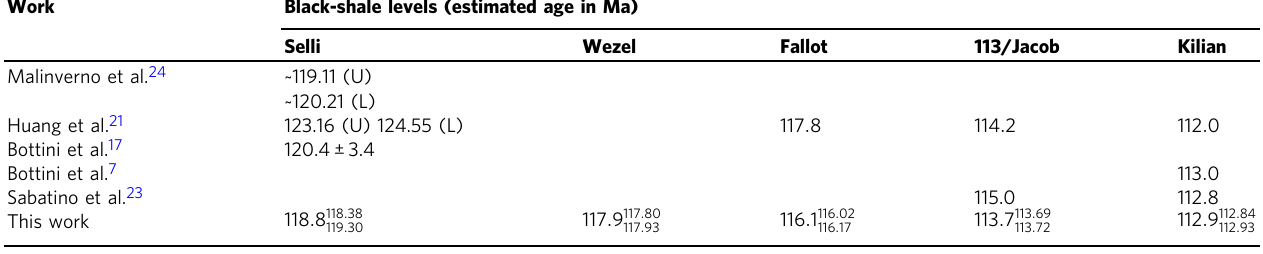
Table 3 Estimated ages of the black-shale levels.